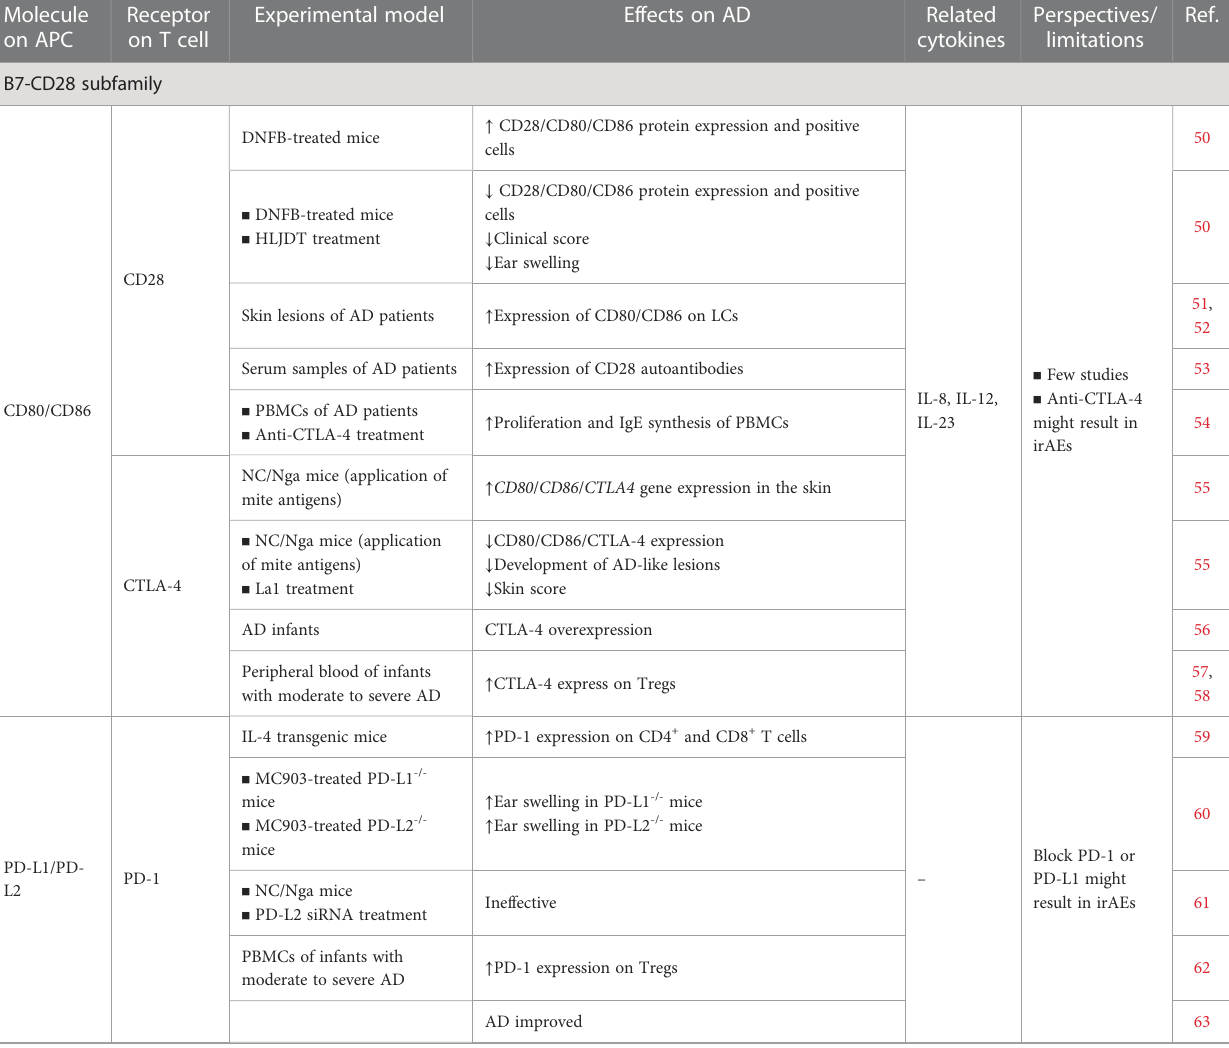
Perspectives/ cytokines limitations